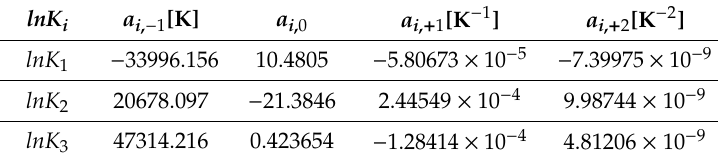
Table 1. The thermal coe ffi cients corresponding to the three equilibria K 1 , K 2 , and K 3 .